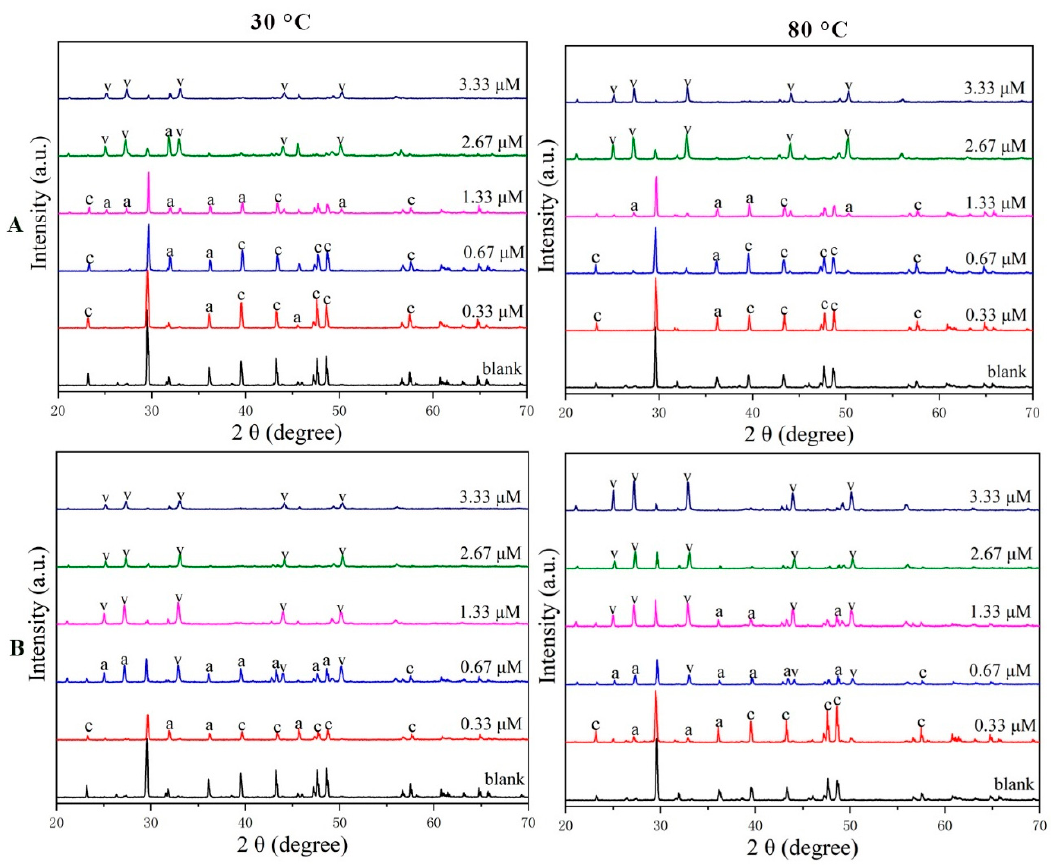
Figure 2. The X-ray diffraction (XRD) results for the depositions with different concentrations of ( A ) polyepoxysuccinic acid (PESA), ( B ) poly acrylic acid (PAA) at 30 °C, and 80 °C. c, a, and v represent calcite, aragonite, and vaterite, respectively.